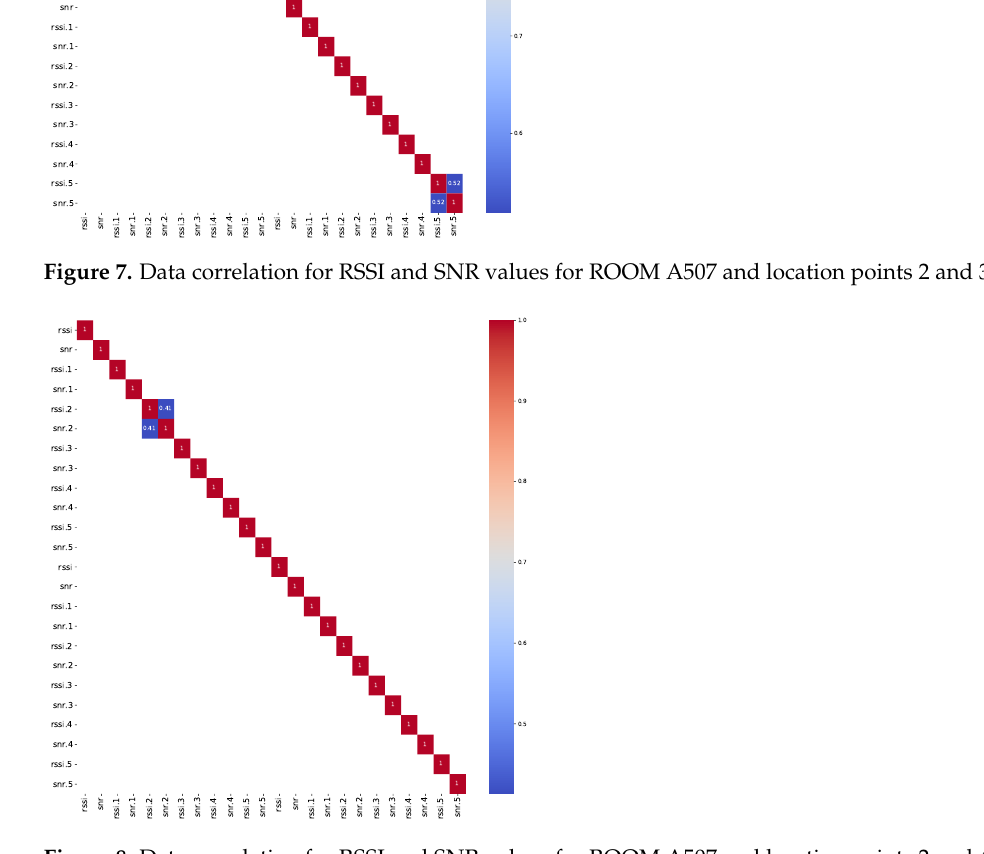
Figure 8. Data correlation for RSSI and SNR values for ROOM A507 and location points 2 and